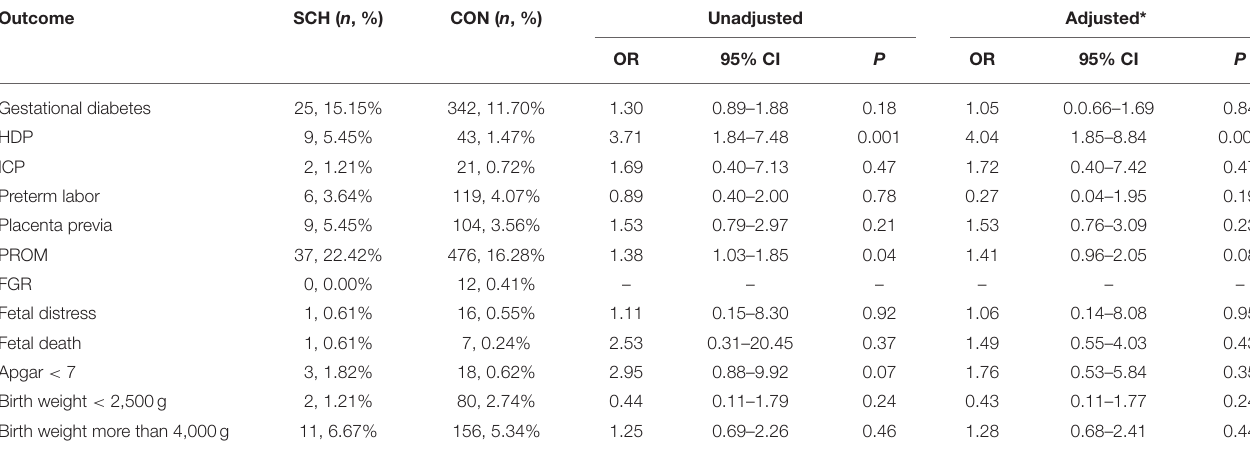
OR 95% CI P OR 95% CI P